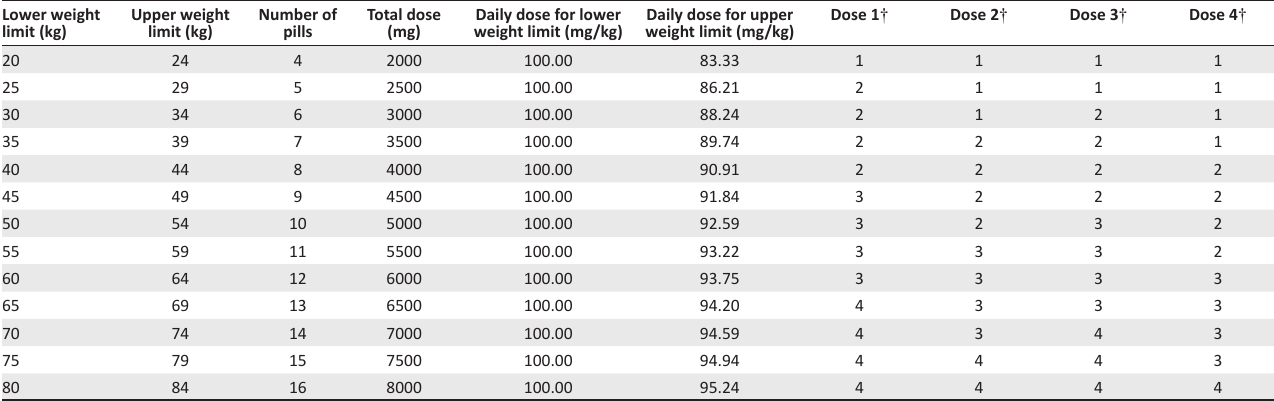
TABLE 5: Flucytosine dosing in children and adults with normal renal function. Lower weight limit